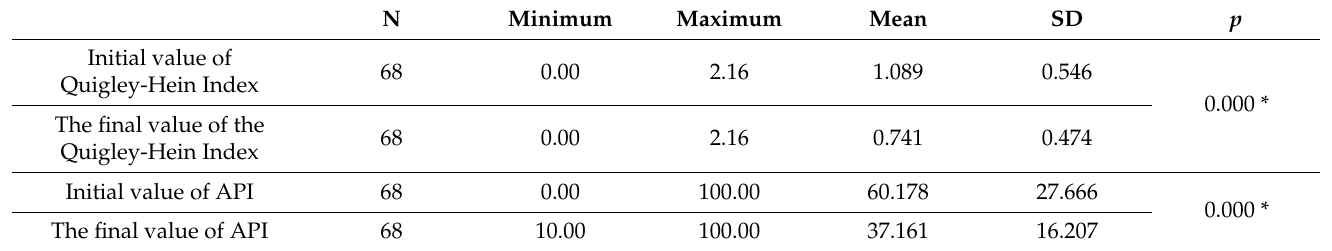
Table 4. Evaluation of dental plaque index Quigley Hein and API before and after the intervention.